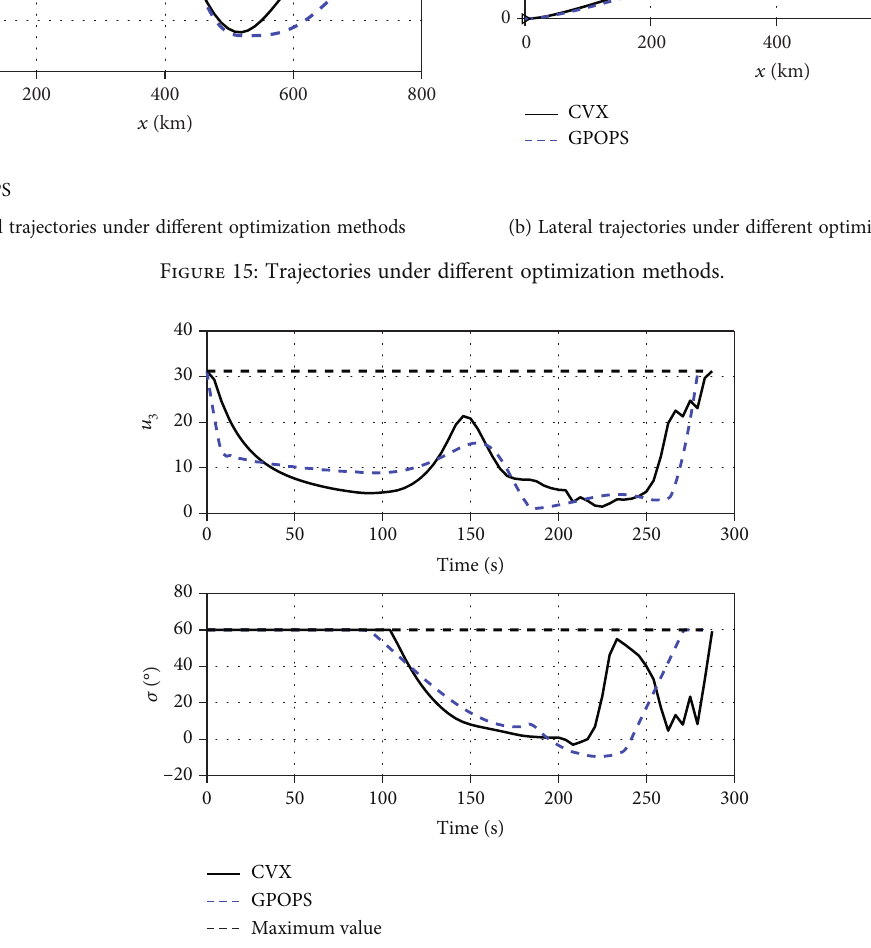
Figure 16: Control variables under di ff erent optimization